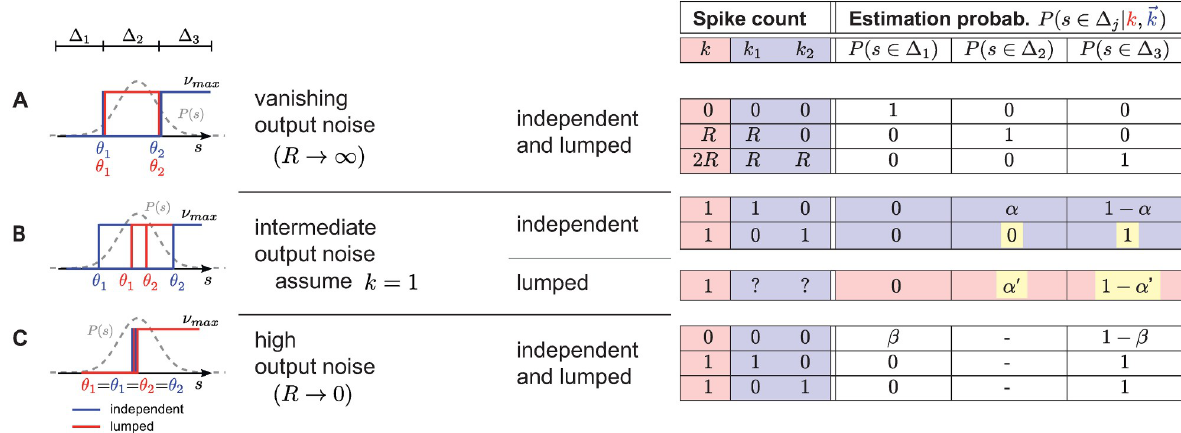
Fig 2. Schematic illustrating the dominance in information of the independent- over the lumped-coding channel. Here, we treat the case of N = 2 cells, vanishing input noise ( σ = 0) and A . vanishing output noise ( R ! 1 ), B . intermediate output noise when the total number of spikes k = k 1 + k 2 = 1, and C . high output noise ( R ! 0). Left: The relative positions of optimal thresholds of both the independent- (blue) and lumped-coding j ~ k Þ for the two different channels. Yellow shading shows where the noise (red) channels. Right: The stimulus “estimation probabilities” P ð s 2 D j entropy is higher in the lumped-coding channel. α , α 0 , and β denote non-zero probability values (see text).